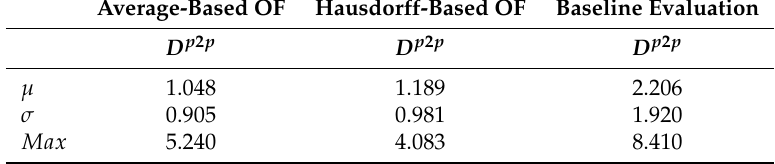
Table 7. Numerical evaluation: Pair-wise distance (in mm) between predicted PCLs and post-surgery models using RF with adaptive weights. The training set is sampled with rate of 65% and 75% due to average and Hausdorff OFs, respectively.